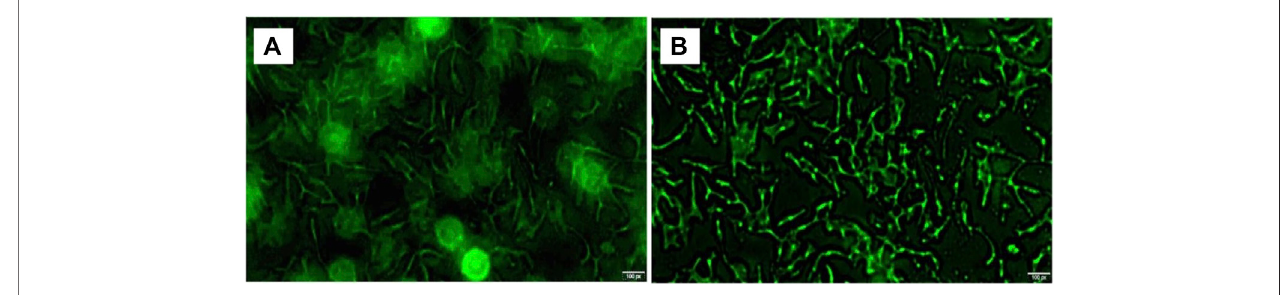
FIGURE 5 | Image of high expression of CD59 on oral squamous cell carcinoma cells (A) and ICT-CMC-CD59sp targeting microspheres ’ killing effect (B) .